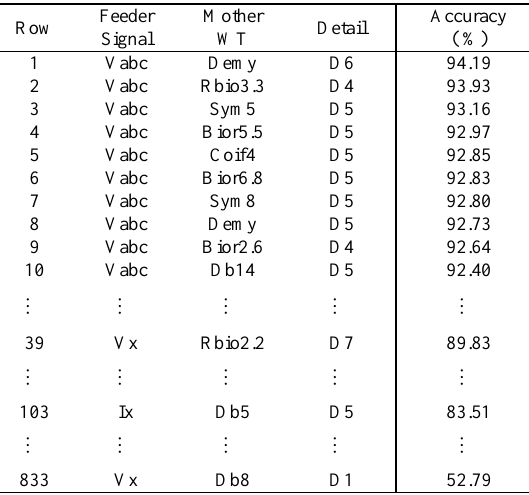
Table 1.The best detection using WT